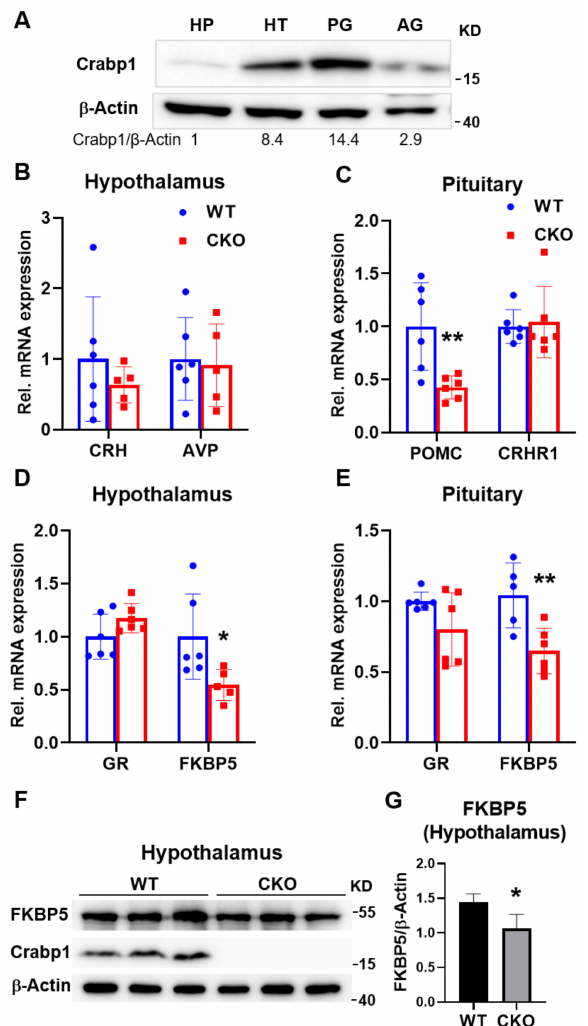
Figure 3. Changes in the expression patterns of key genes relevant to the regulation of HPA axis in hypothalamus and pituitary gland tissues. ( A ) Crabp1 protein levels in the hippocampus (HP), hypothalamus gland (HT), pituitary gland (PG), and adrenal gland (AG). ( C , D ) Changes in gene expression in the hypothalamus gland ( B , D ) and pituitary gland ( C , E ) of WT ( n = 6) and CKO ( n = 6) mice. ( F , G ) FKBP5 protein levels in the hypothalamus gland of WT ( n = 3) and CKO ( n = 3) mice. β -actin was used as a loading control. Western blot quantification shown in ( G ). Results are presented as means ± SD, * p ≤ 0.05, ** p ≤ 0.01, compared with WT